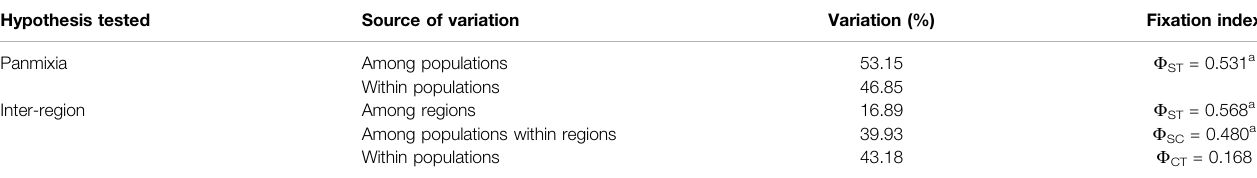
TABLE7| Hierarchicalanalysisofmolecularvariance(AMOVA)basedon trn L UAA F — trn F GAA sequencesfordifferentstructuringhypothesesofwild Aspalathuslinearis based on six wild populations in two different sampling regions (Cederberg in the Western Cape and Suid Bokkeveld in the Northern Cape). Hypothesis tested Source of variation Variation (%) Fixation index